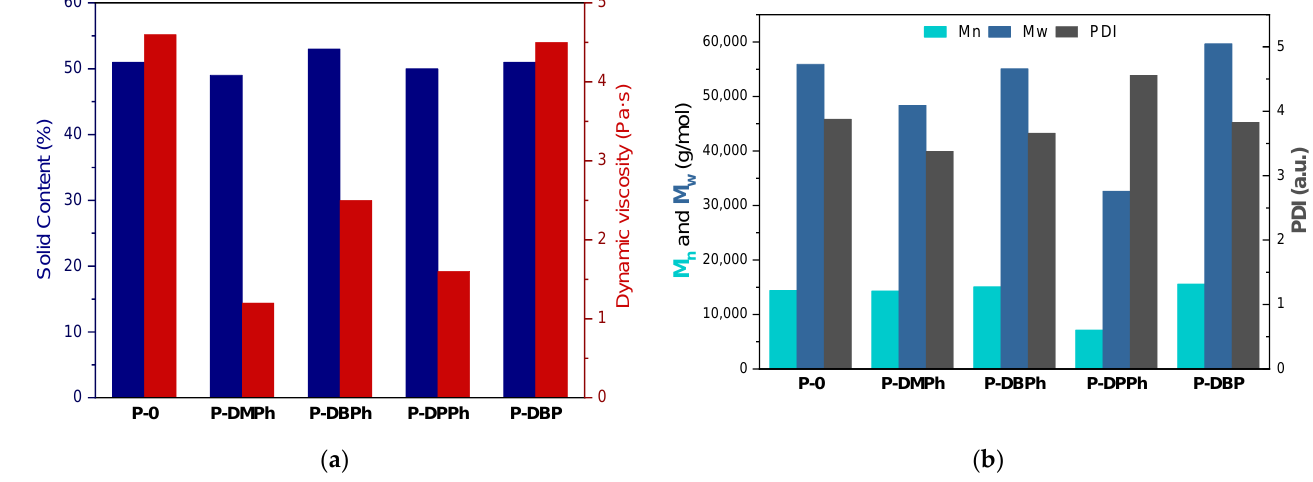
Figure 3. The values of dynamic viscosity and solid content of the P-telomers syrups ( a ), molecular weights (M w , M n ), and polydispersity (PDI) of the P-telomers ( b ). The incorporation of groups derived from P- telogens (DMPh, DBPh, DPPh, and DBP) in the structure of the oligomers was checked by analyzing the FTIR spectra of the tested phosphorus compounds and dry telomers (Figure 4). The telogen spectra revealed peaks in the range 1220 – 1270 cm −1 , attributed to P = O stretching vibrations in the telogen structures (DMPh, DBPh, and DBP), and at a wavelength of 1188 cm −1 , derived from P-O-Ar stretching (DPPh). In the case of FTIR spectra of dry telomeres, a slight shift of the above-mentioned peaks (from 13 to 29 cm −1 ) was observed. It was probably caused by the presence in the structure of linear telomers of hanging hydroxyl groups derived HEA monomer [38]. Nevertheless, the FTIR results confirm the formation of phosphorus-containing oligomers, i.e., P-telomers. Their structures are also shown in Figure 4.